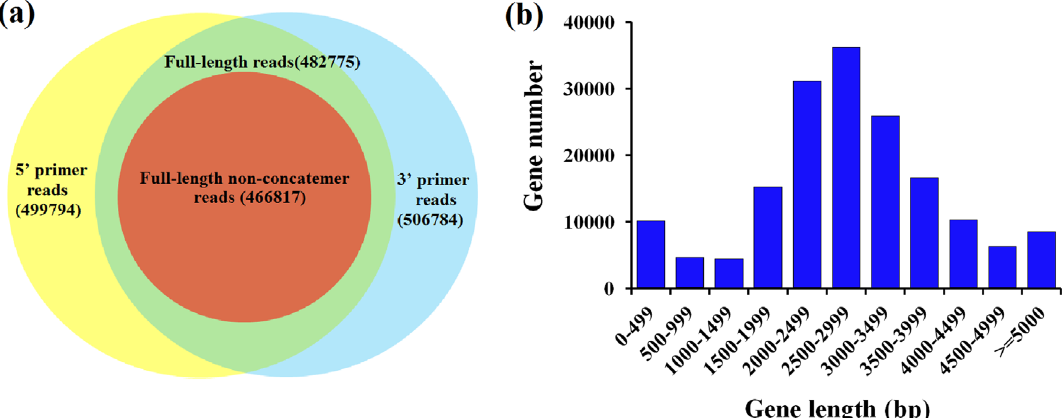
Figure 1. Overview of PacBio sequencing in Microplitis pallidipes . (a) Numbers of different types of PacBio reads in M. pallidipes . Blue and green circles represent 3 0 and 5 0 primer reads, respectively while green indicates their intersection. The red circle represents the full-length non- concatemer reads. (b) Length distribution of M. pallidipes unigenes obtained using PacBio Iso-Seq. Gene length is on the x -axis and number of genes is on the y